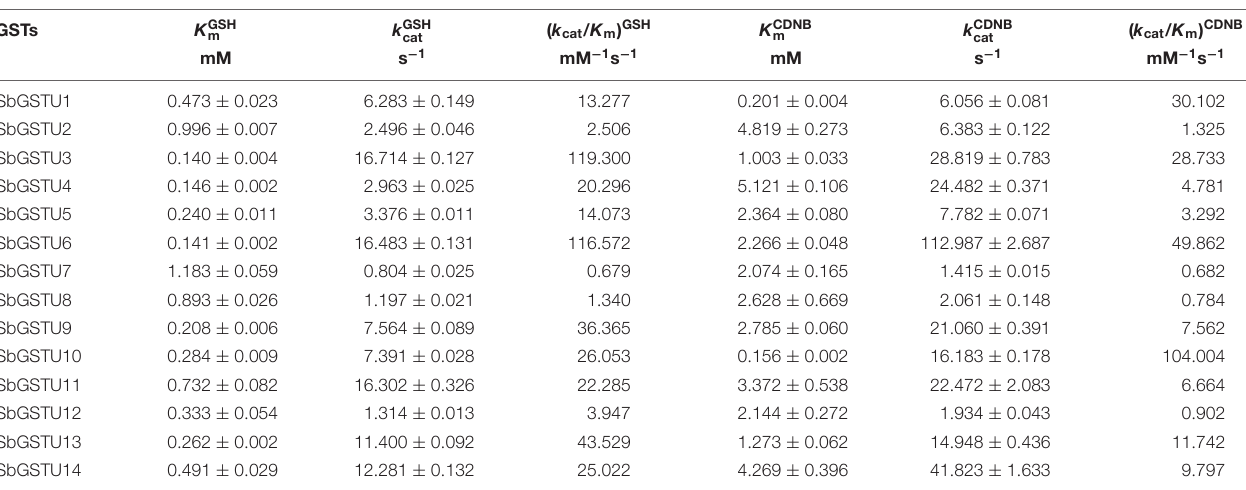
Values shown are means ± SD, calculated from three